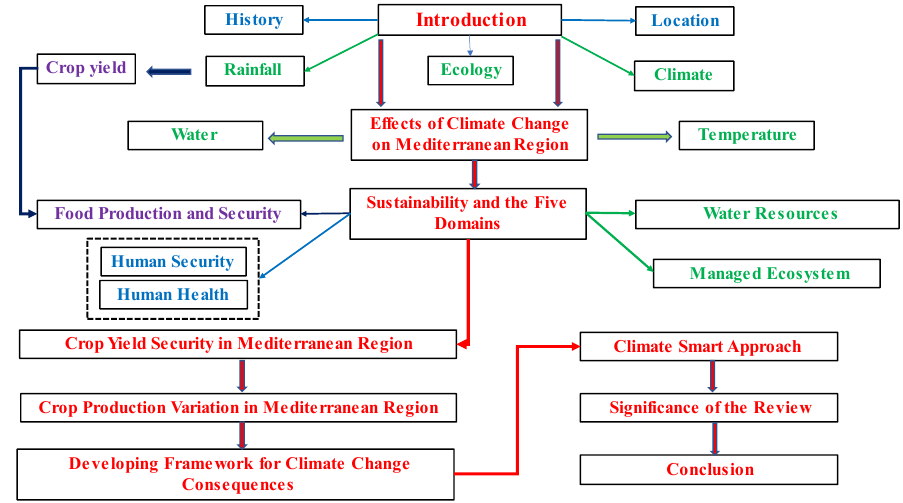
Figure 4. Flowchart of the topics included in the review paper.